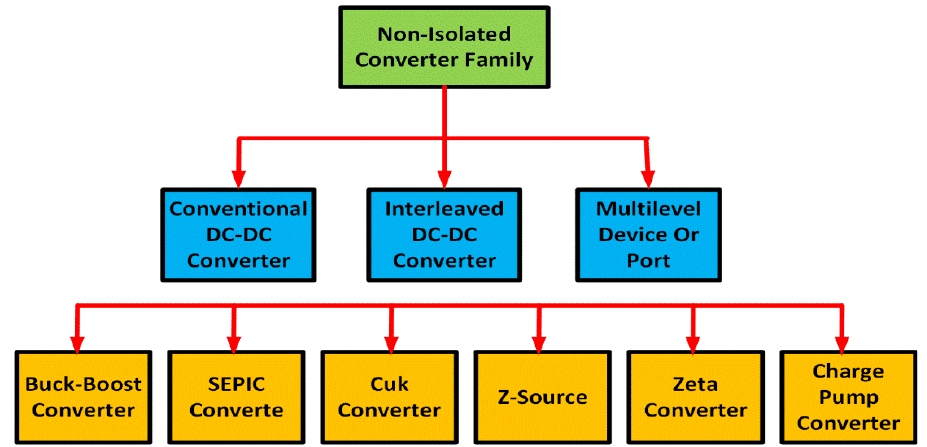
Figure 4. Various DC-DC non-isolated converter topologies.